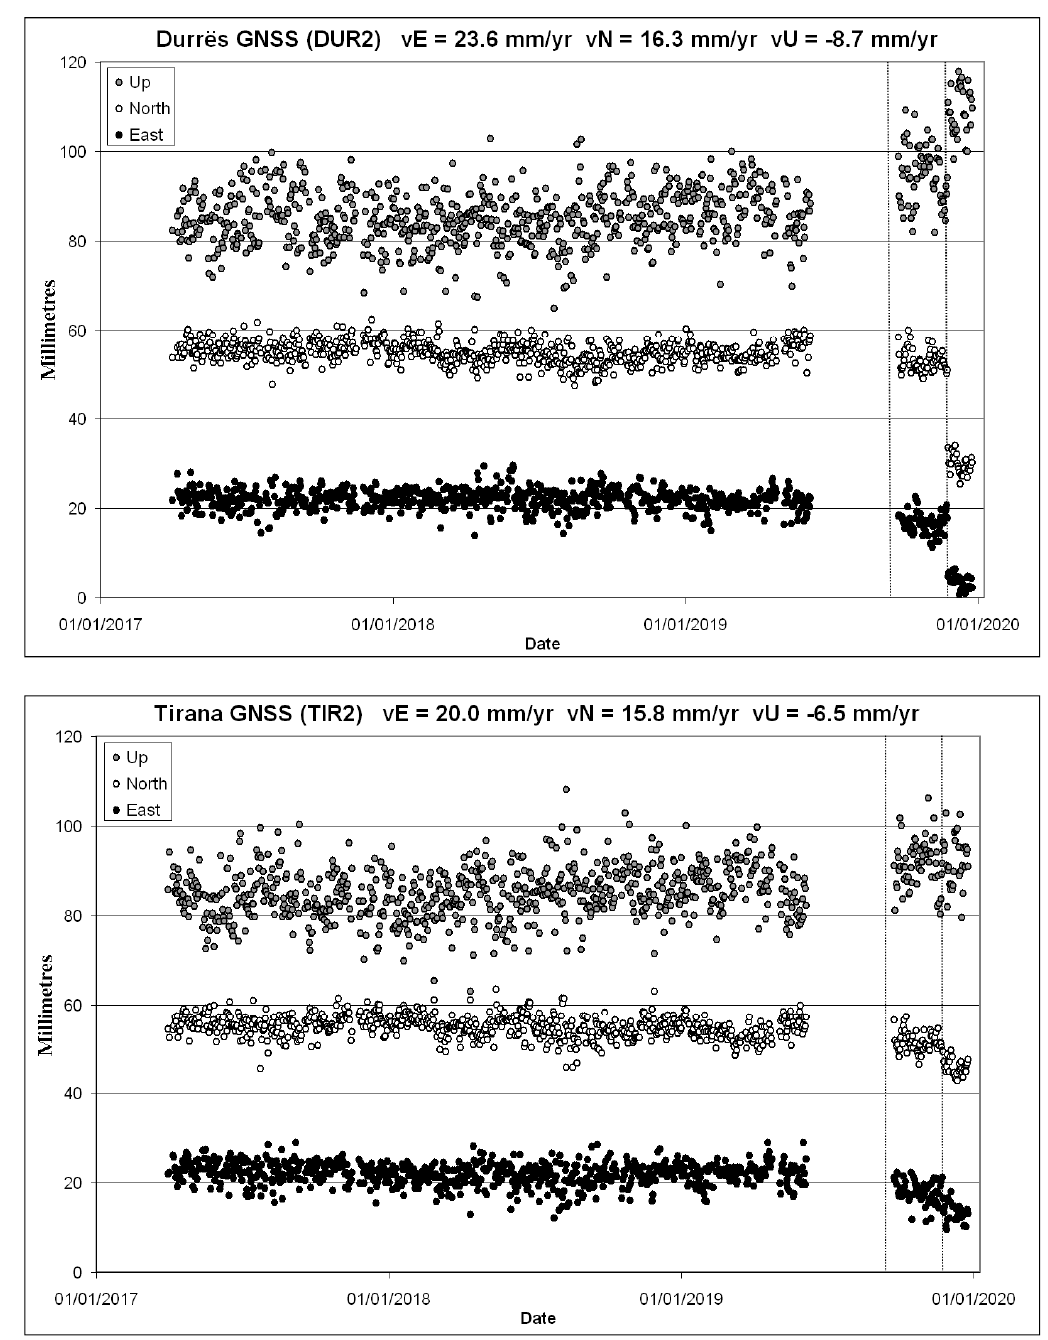
Figure 3. GNSS time series (Up, North, East component from top to bottom series) at the permanent stations of Durrës (DUR2; top panel) and Tirana (TIR2; bottom panel). The figure shows the residuals after removing the tectonic velocities that are also estimated. The offsets produced by the two earthquakes of September 21, 2019 and November 26, 2019 are visible and can be measured (see Table 3). Vertical lines indicate timing of earthquakes.